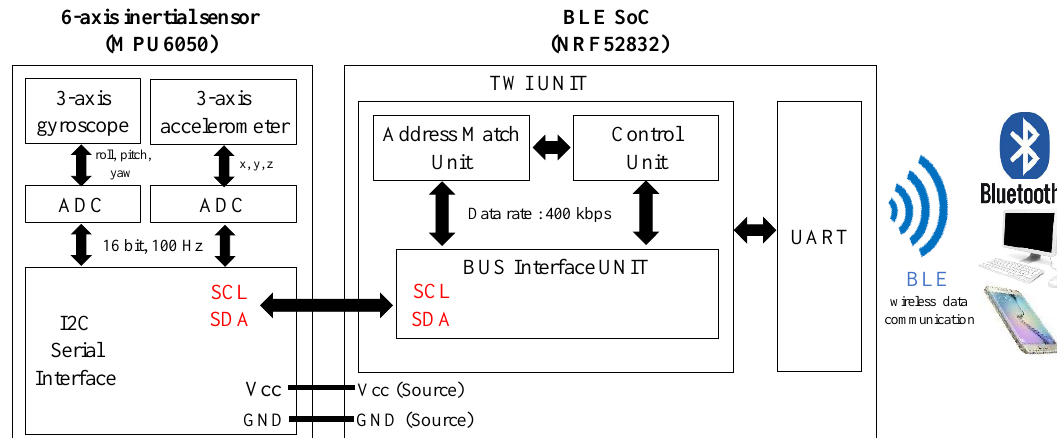
Figure 2. Block diagram of the epidermal, six-axis inertial measurement unit (IMU) using wireless data communication. ADC: analog-to-digital converter; UART: universal asynchronous receiver/transmitter; SDA: serial data; SCL: serial clock; TWI: two-wired serial interface.